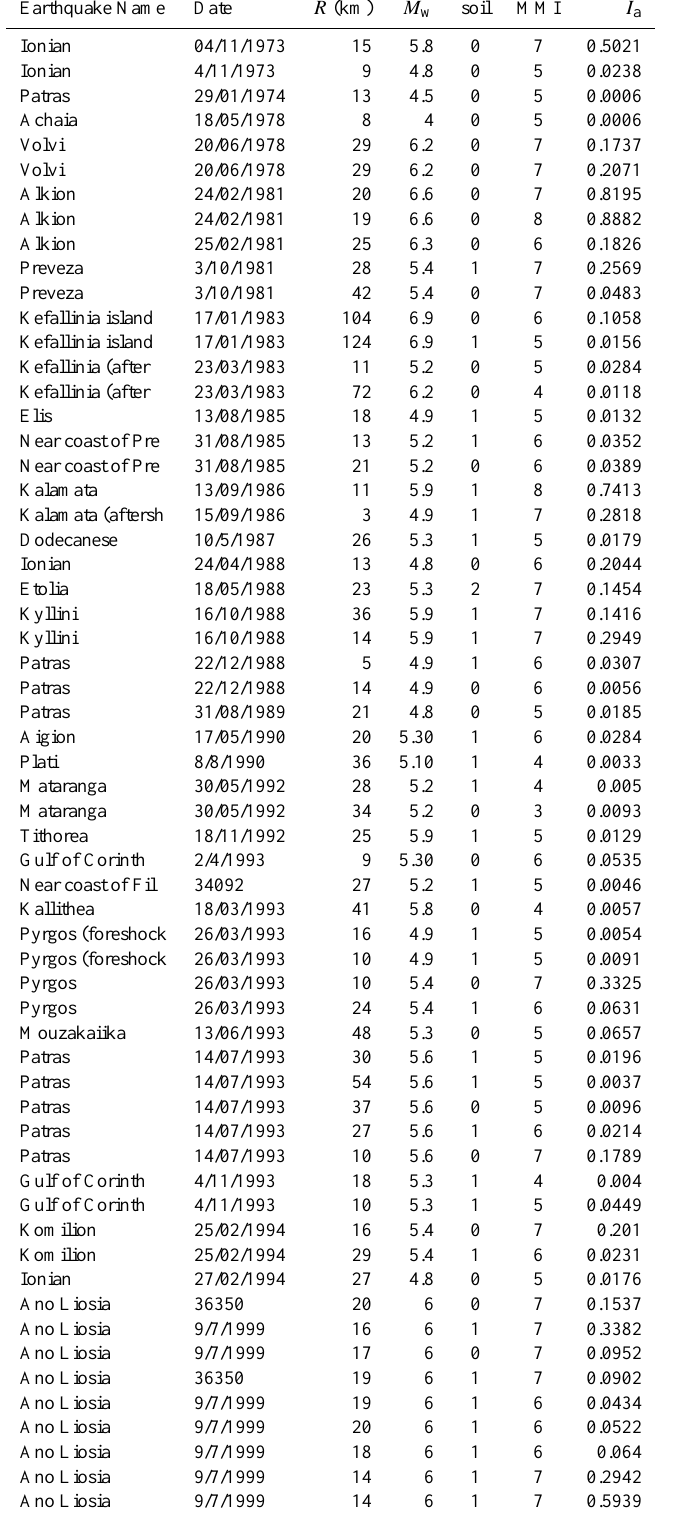
Table 1. Database of strong motion records used. R is the epicentral distance, M w is the body wave magnitude, Soil parameter is 0 for